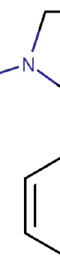
Figure 9. Chemical structure of nicotine.